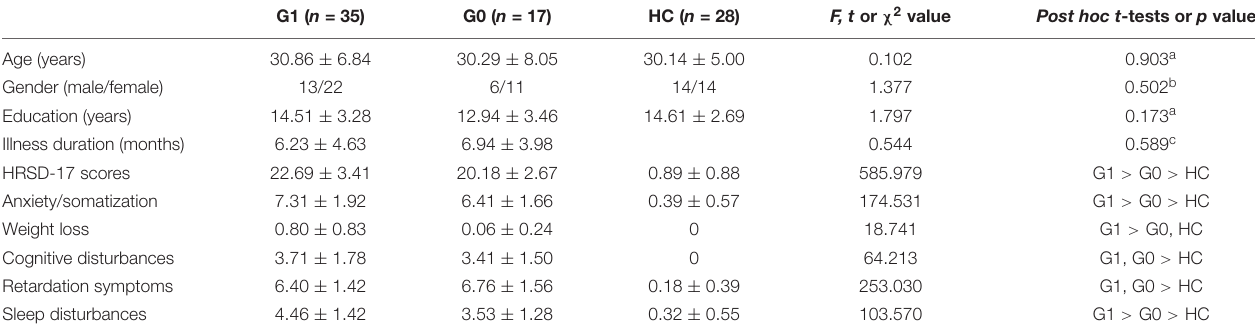
TABLE 1 | Demographic and clinical characteristics of the